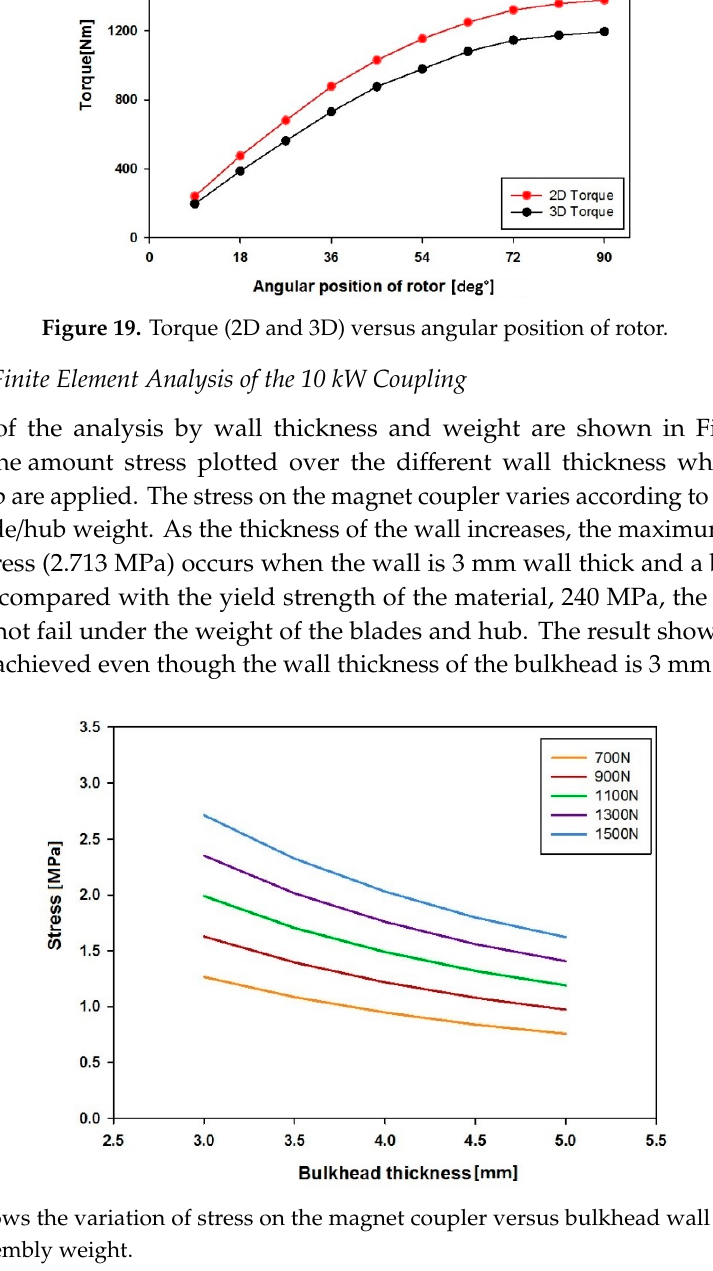
Figure 19. Torque (2D and 3D) versus angular position of